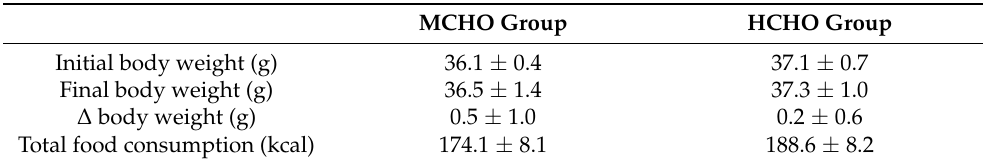
Table 2. Body weight and food consumption of mice in the moderate-carbohydrate diet (MCHO) and the high-carbohydrate diet (HCHO)